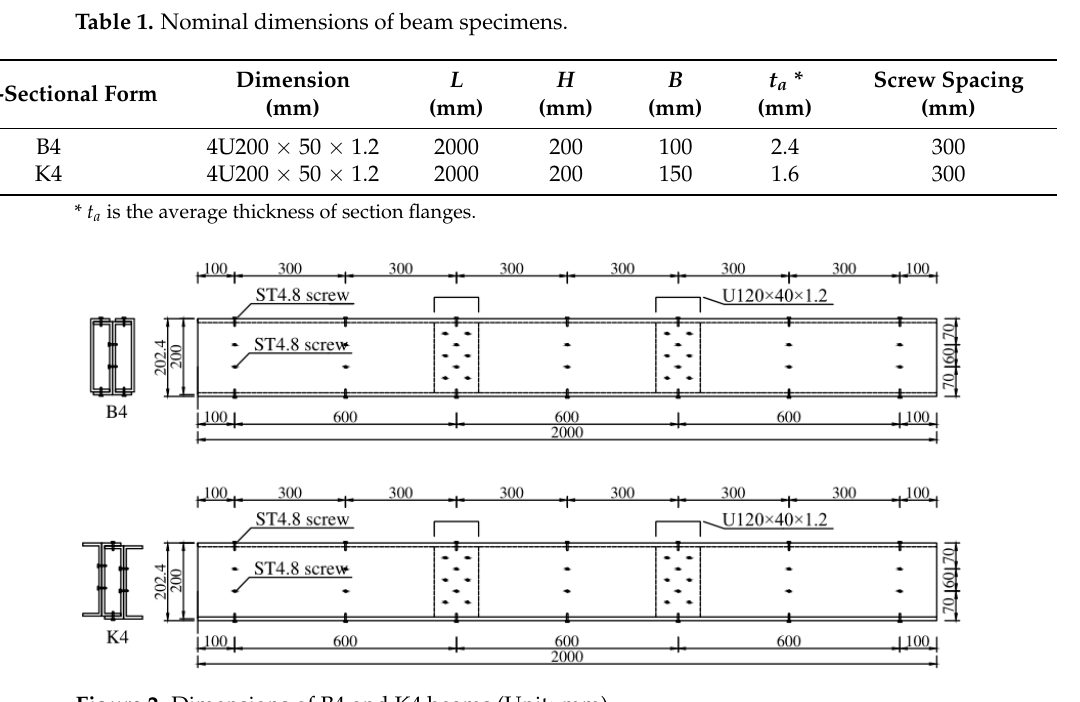
Figure 2. Dimensions of B4 and K4 beams (Unit: mm). Table 1. Nominal dimensions of beam specimens.